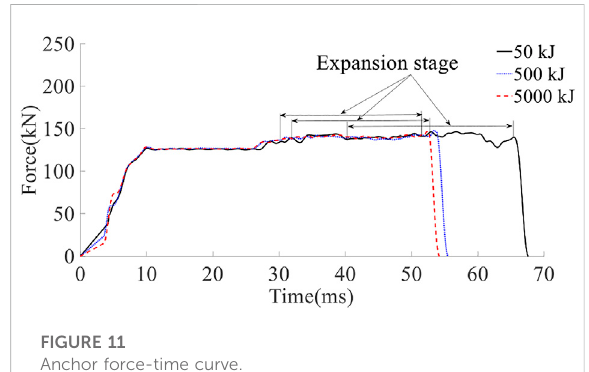
FIGURE 10 Deformation of bolt with time at different impact energies.